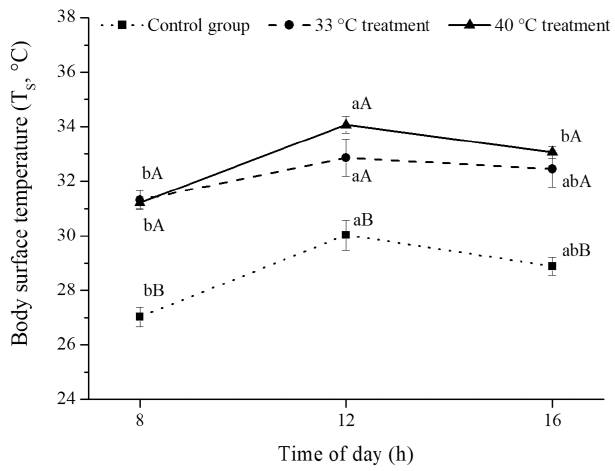
, °C) at different treatment Fig 3 . Body surface temperature (T S temperatures. Different capital letters in the same time of day and different lowercase letters in the same treatment indicate a significant difference (Tukey test, p < 0.05).